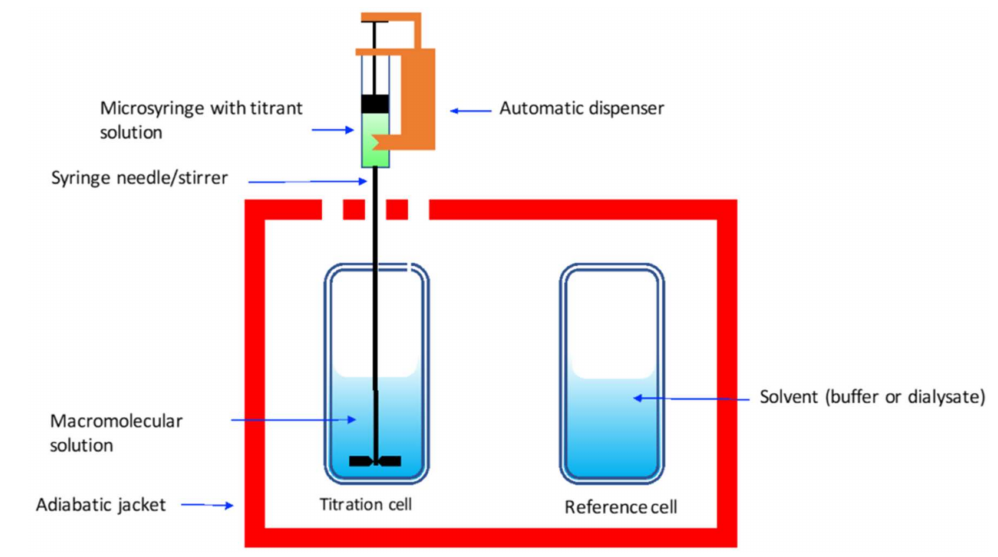
Figure 9. Schematic view of an isothermal titration